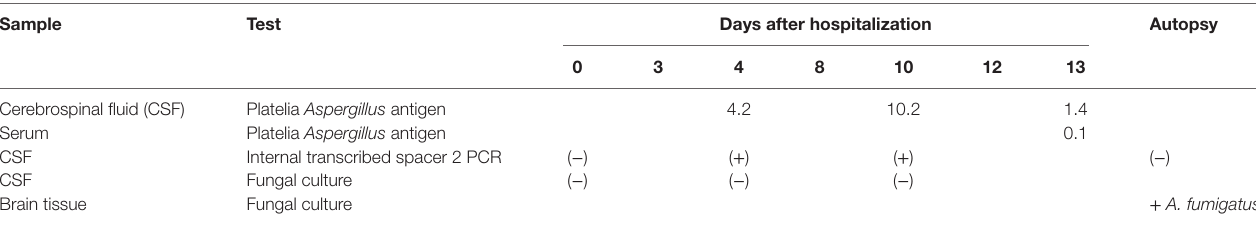
taBle 1 | Summary of laboratory findings for fungal cultures, PCR, and galactomannan assays.